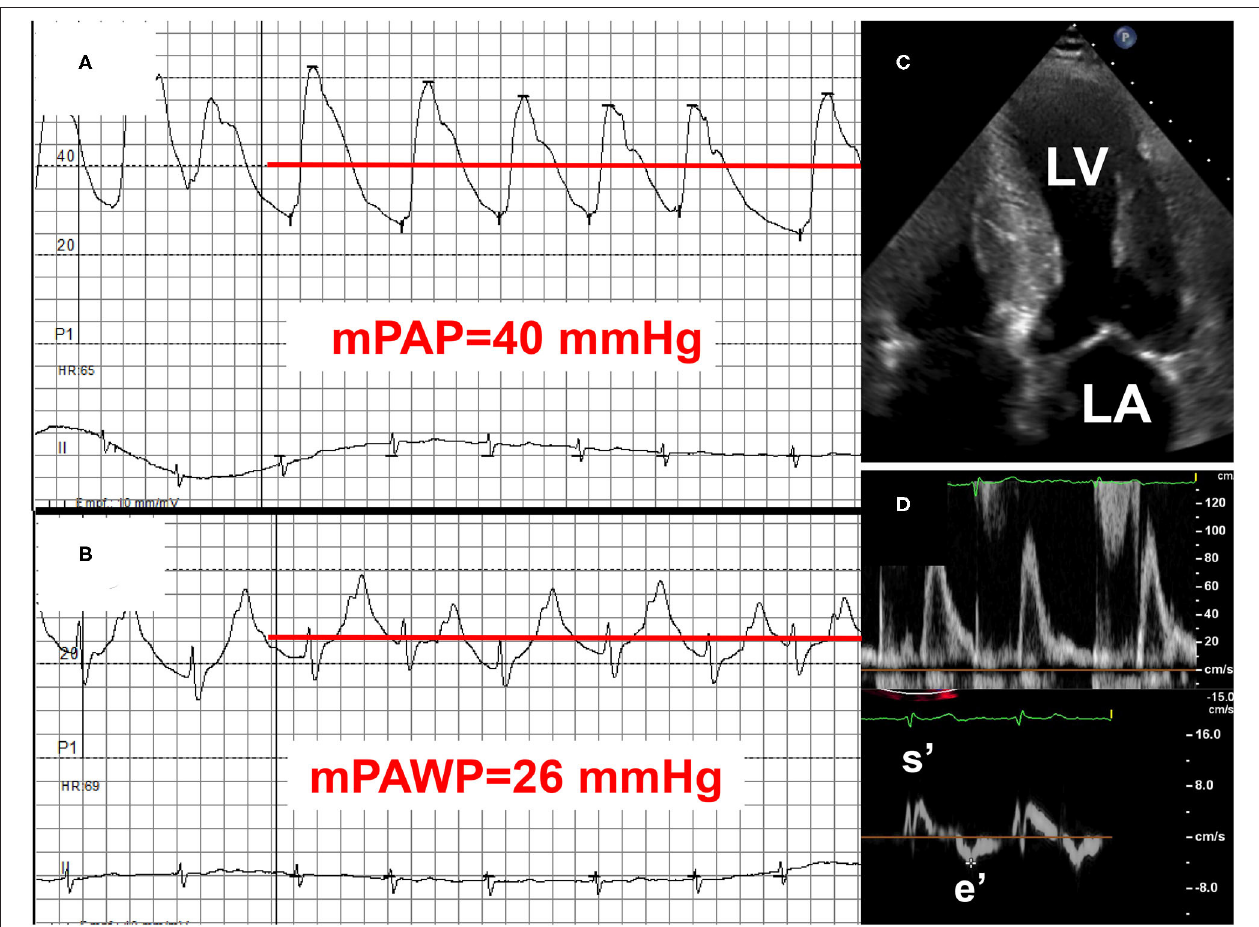
FIGURE 5 | Example 2 of a patient with a mid-range left ventricular ejection fraction (LVEF) and pulmonary hypertension (PH): 75-year old man with transthyretin cardiac amyloidosis (positive technetium pyrophosphate scan). NYHA class III. LVEF 46%. Mean pulmonary artery pressure (mPAP): 40 mmHg (A) , mean pulmonary artery wedge pressure (mPAWP): 26 mmHg (B) , pulmonary vascular resistance: 2.5 Wood units. Left atrial pressure elevation is due to myocardial amyloid deposition (C) with significant systolic [long axis function, reduced systolic mitral annular velocity (s ′ )] and diastolic dysfunction [markedly reduced peak early diastolic mitral annular velocity (e ′ ); (D) ]. Management primarily with loop diuretics and spironolactone; tafamidis may be considered but may have limited effect in this advanced disease stage (NYHA III). LA, left atrium; LV, left ventricle.